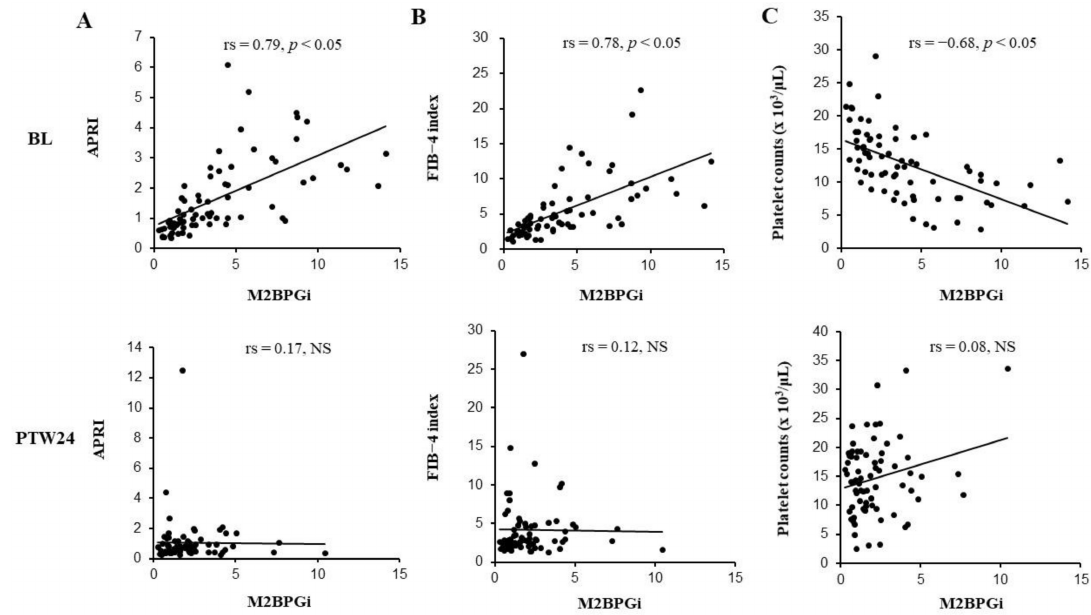
Figure 2. The correlation between mac-2 binding protein glycosylation isomer (M2BPGi) levels and APRI ( A ), FIB-4 index ( B ) or platelet counts ( C ). Before the combination therapy with daclatasvir (DCV) and asunaprevir (ASV), M2BPGi levels significantly correlated with APRI ( A ), FIB-4 index ( B ), and platelet counts ( C ), while these significant correlations disappeared 24 weeks after the combination therapy with DCV+ASV (PTW24: Post-treatment week 24). BL: Baseline; COI: Cutoff index; NS: Not significant; rs: Spearman’s rank correlation